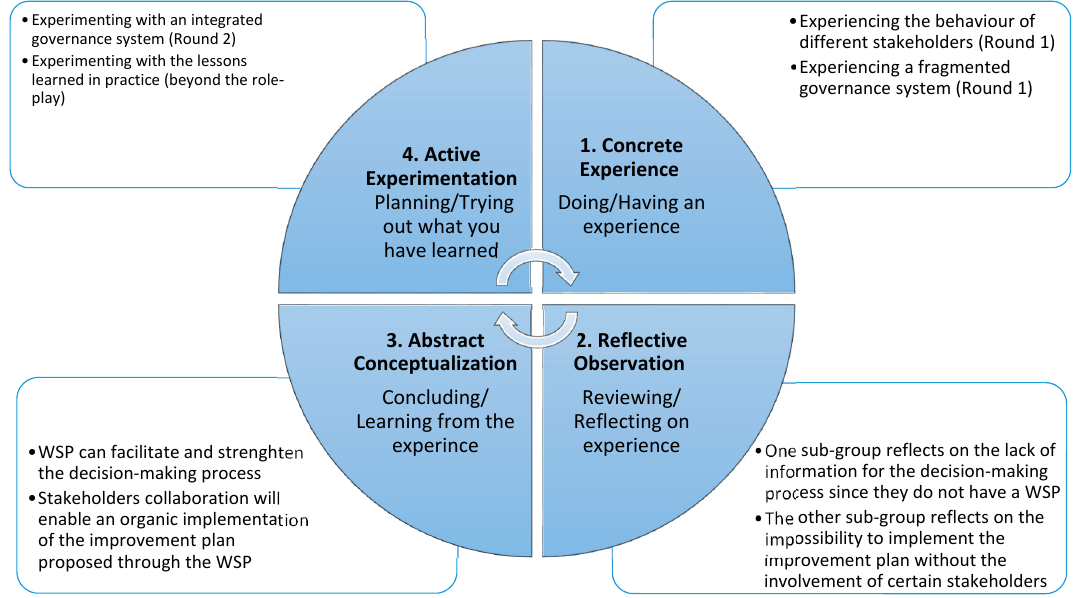
Figure 2. Kolb’s experiential learning cycle stages through the WSP role-play.